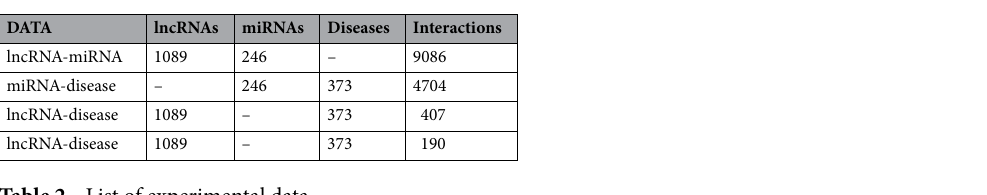
Table 2. List of experimental